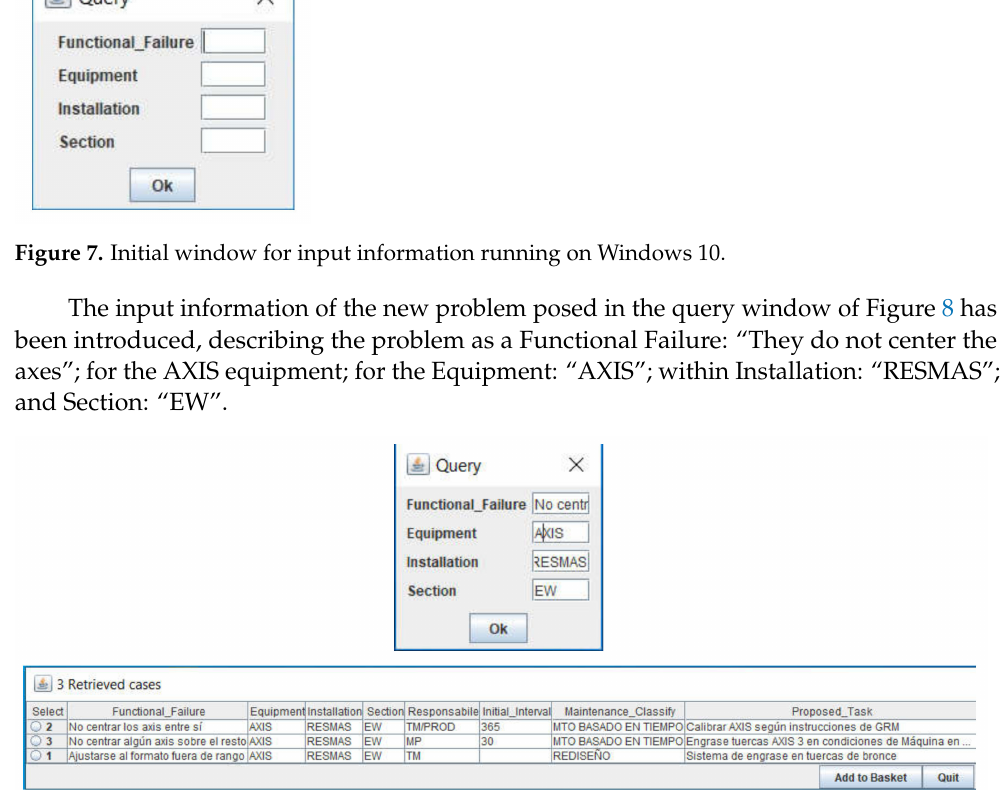
Figure 8. Problem data input (above) and output window with the three similar